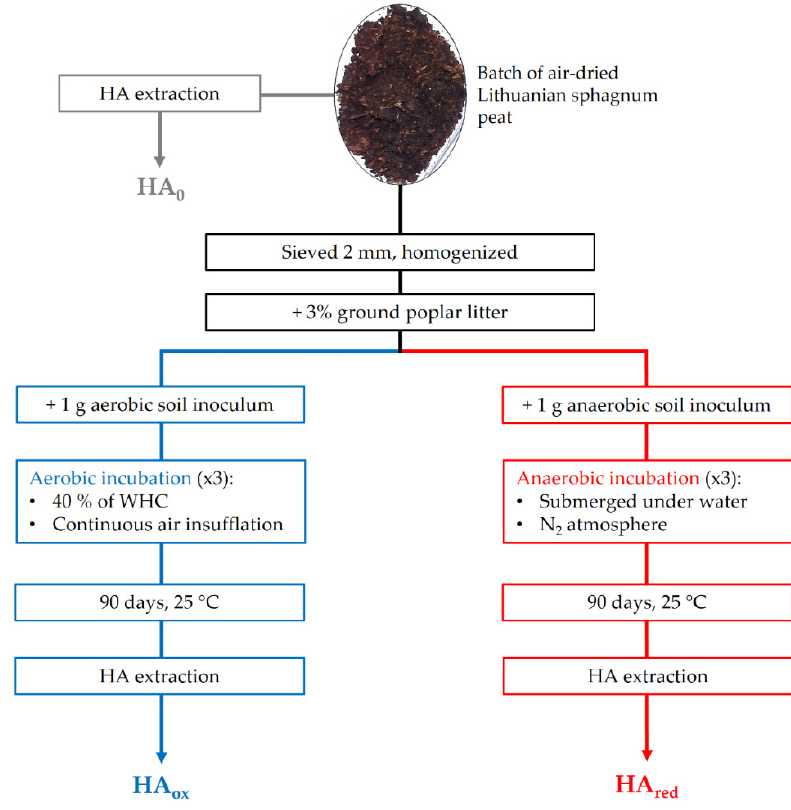
Figure 1. Schematic representation of the experimental